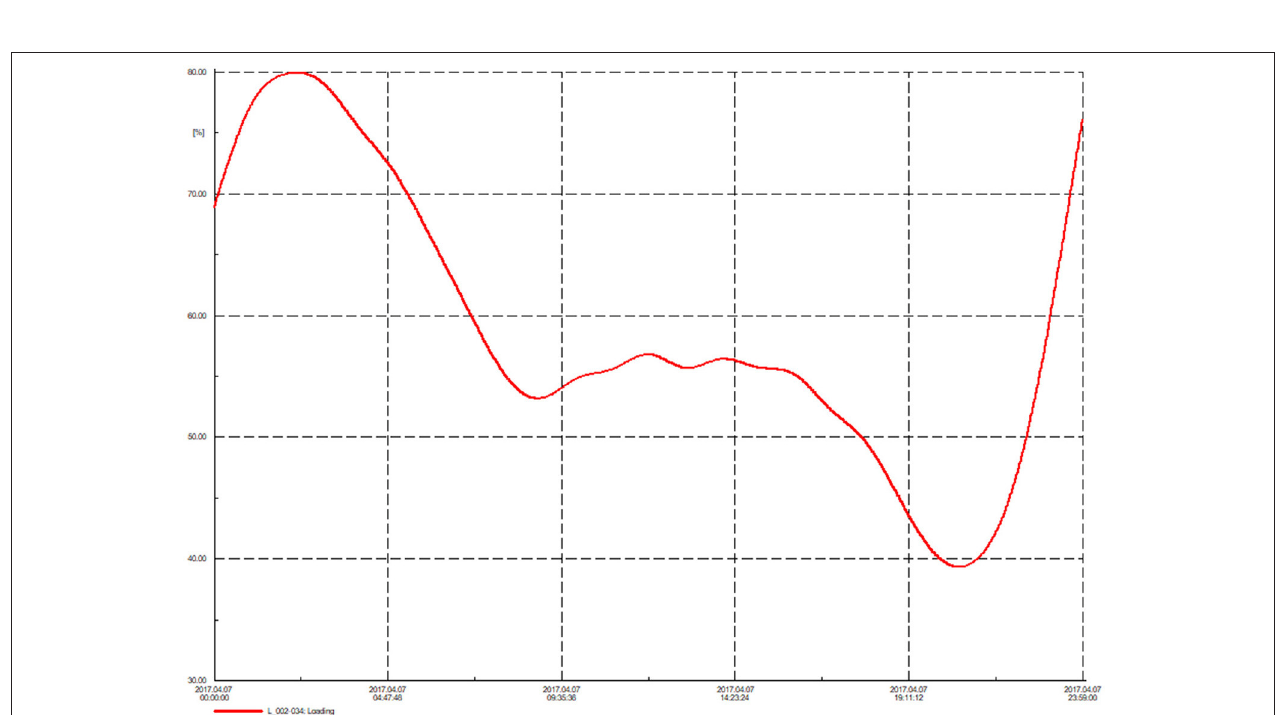
FIGURE 12 | Test case 2—with